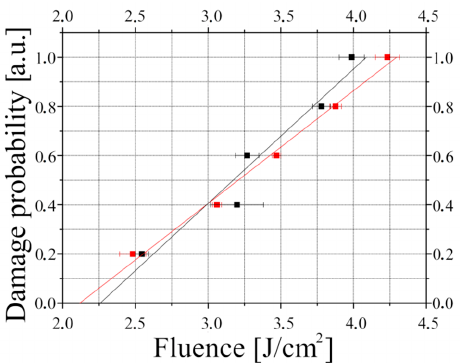
Figure 7. A comparison of optical damage probability measured in the preliminary tests by S-on-1 (red squares) and R-on-1 (black squares) procedures with the exposure duration of 1 s, PRR of 12 kHz, and the pulse width of 18 ns. The fluence errors were caused by a cumulative inaccuracy of the determining. The statistical parameters of the S-on-1 and R-on-1 test procedures were determined from the experimental data and calculation by Exps. (4)–(6) with the fixed confidence probability P T = 0.95 (Table 1). Table 1. The average error (cid:3495)< 𝑾 𝑻𝟐 > , the K coefficient of the error dispersion at the confidence probability of PT = 0.95, the average LIDT fluence <W T >, the 0-probability LIDT fluence W 0 for the S-on-1 and R-on-1 tests with damaged site number N D . Test Pro- cedure